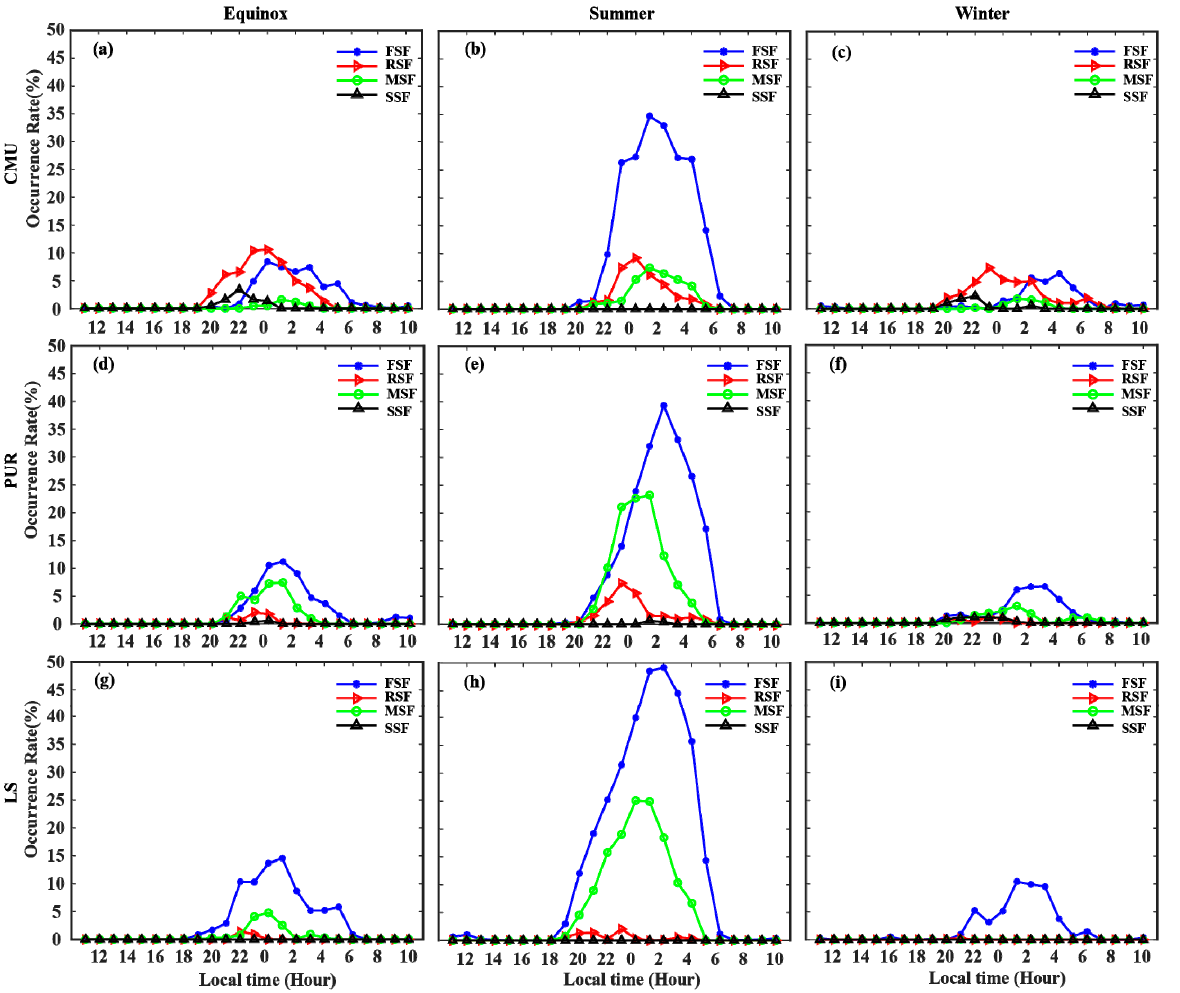
Figure 3. The diurnal variation in occurrence rate of each type of SF during three seasons at ( a – c ) CMU, ( d – f ) PUR, and ( g – i ) LS in 2016. The formula for calculating LT is LT = UT + 7 h for the longitude of 100° E.